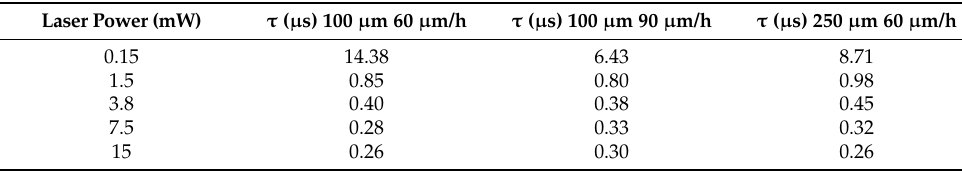
Table 2. Carrier lifetime data for each sample as a function of laser